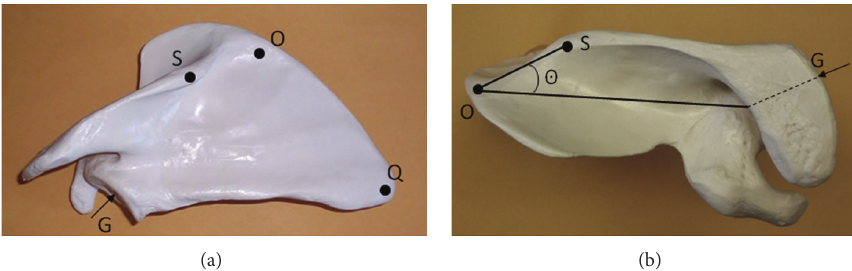
Figure 1: (a) Posterior view of the scapula. The following points are shown: G: center of the glenoid, Q: vertex of the inferior angle of the scapula, O: junction of the medial border of the scapula with the medial border of the scapular spine, S: is the point where the medial and lateral parts of the edge of the scapular spine meet. (b) Superior view of the scapula. Points O, S, and G are shown (G is covered by the acromion); Θ is defined as the angle between OS and